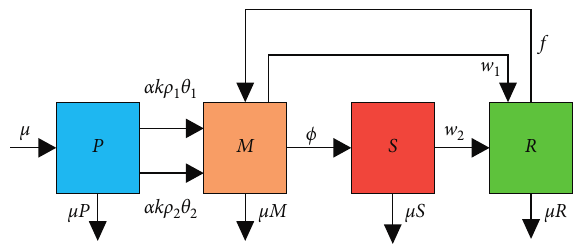
Figure 1: The flow diagram of the PMSR